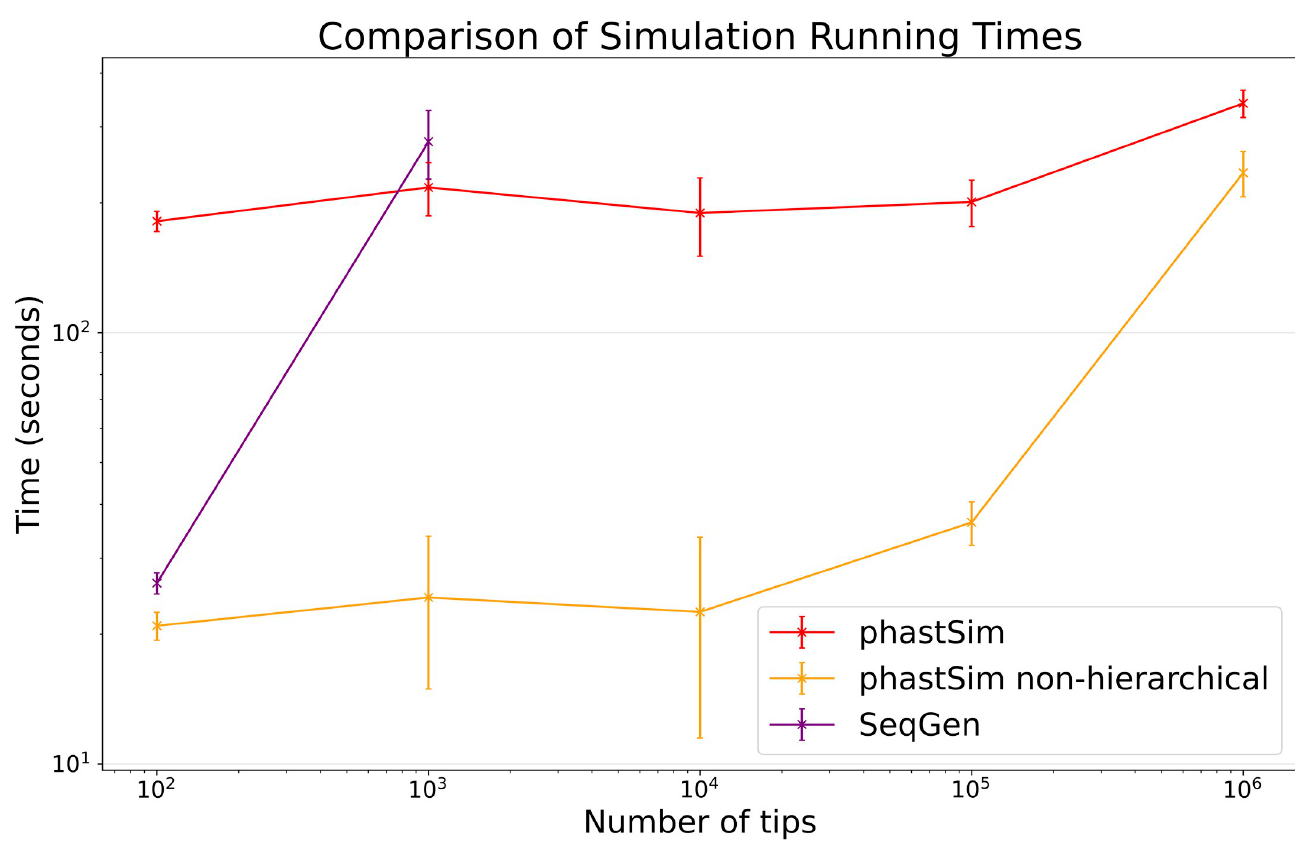
Fig 4. Comparison of running times of different simulators in a scenario similar to E. Coli outbreak data. On the Y axis we show the number of seconds it takes to perform simulations using different software. On the X axis is the number of tips simulated. Each point represents ten replicates. We do not run Seq-Gen for more than 1000 tips due to high computational demand. In red is the time to run phastSim, and in orange is the time for phastSim with the simple, non- hierarchical approach. In purple is the time demand of Seq-Gen.